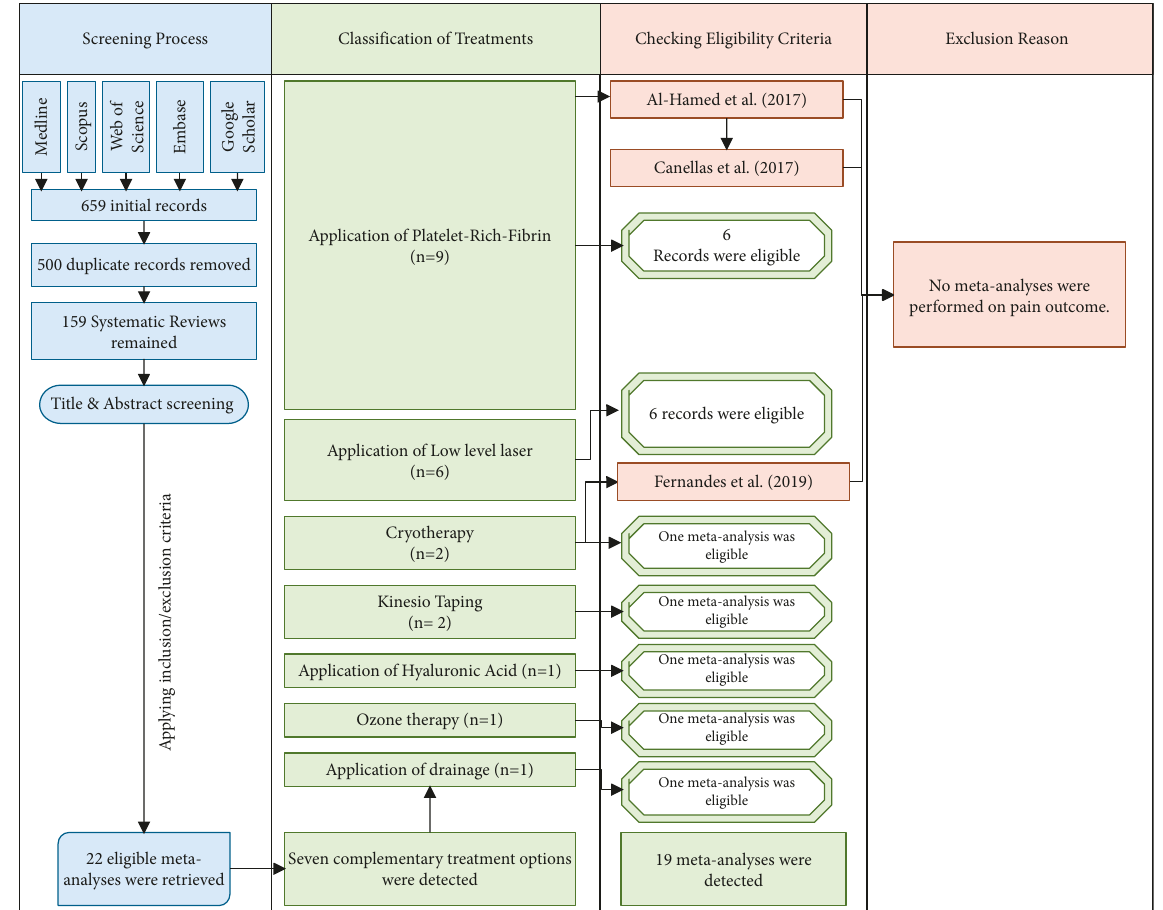
Figure 1: Diagram of the literature search and identification of potentially eligible